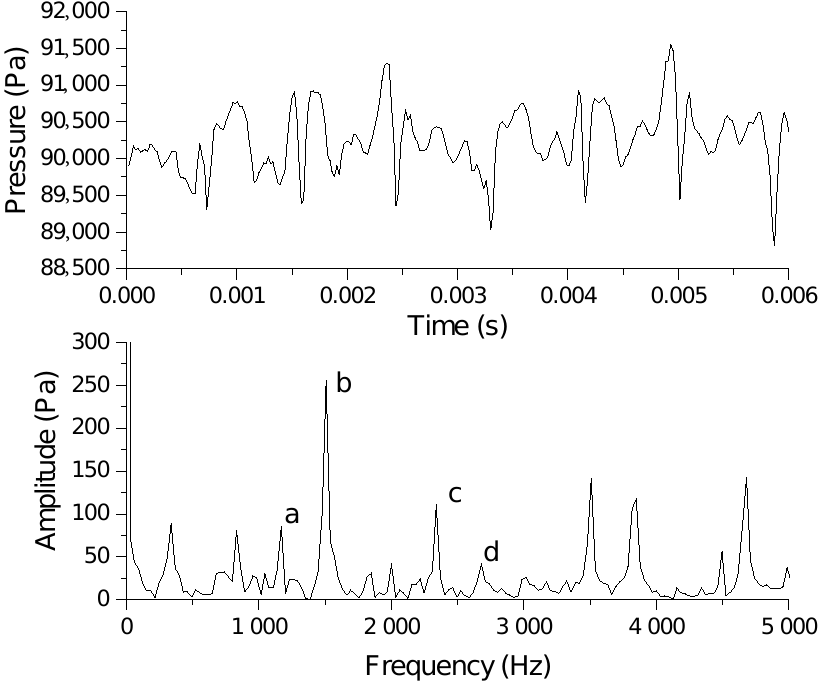
Figure 15. The pressure signal and its FFT to observe the